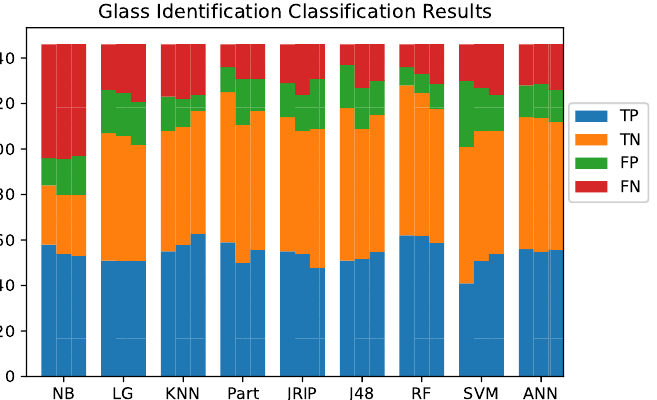
Figure A3. Graph corresponding to the User Knowledge Modeling dataset. In blue are true positives, in orange are true negatives, in green are false positives, in red are false negatives, and in purple are unclassified instances.